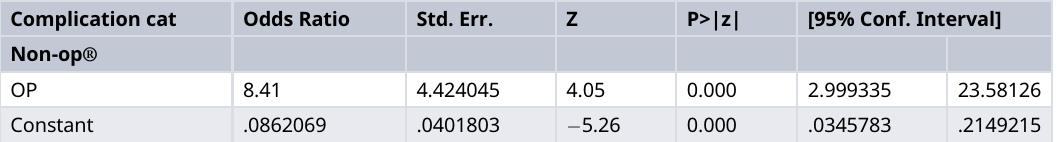
Table 3. Binary Logistic Regression for dependent outcome complication (Note: ® = Reference